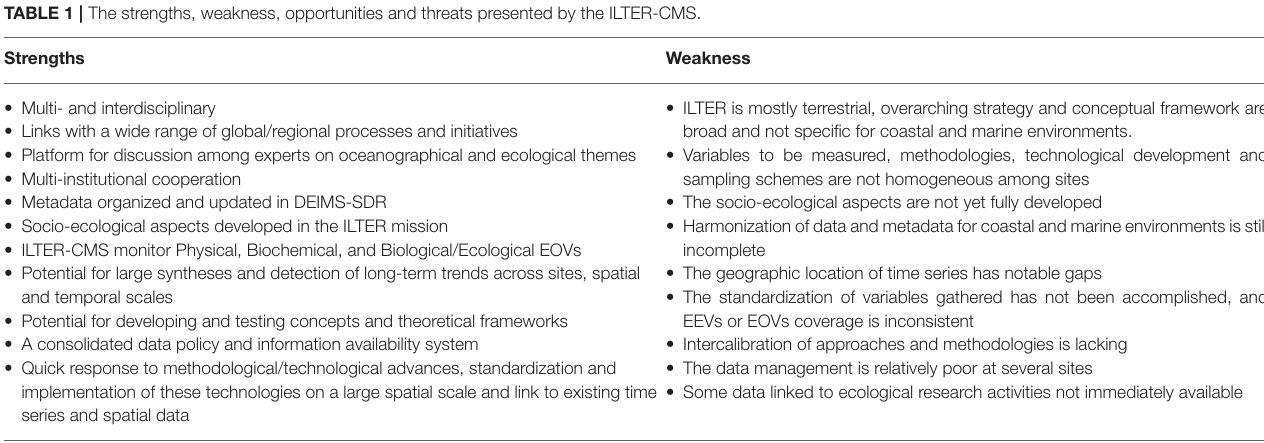
TABLE 1 | The strengths, weakness, opportunities and threats presented by the ILTER-CMS. Strengths